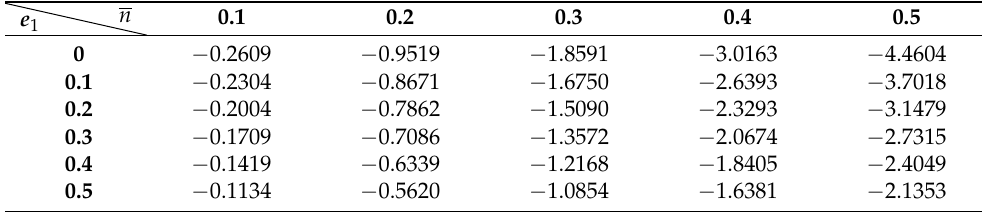
√ Table 4. Values for C f Re x , when e 2 = 0.1, γ = 0.1, δ = 0.2, α 1 , α 2 = 0.1, M = 0, N 1 = 0, Ω = 0.5, x